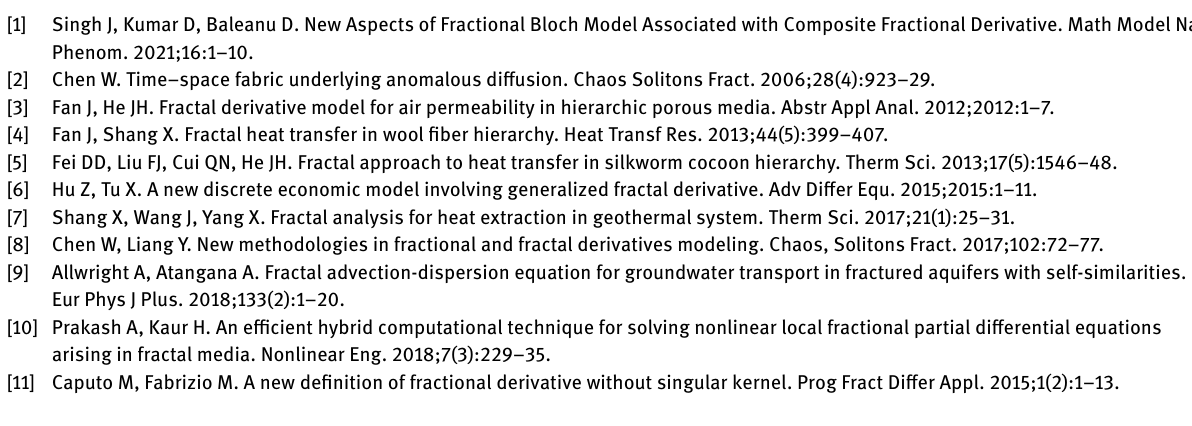
, M , M ) on several distinct orders u v w